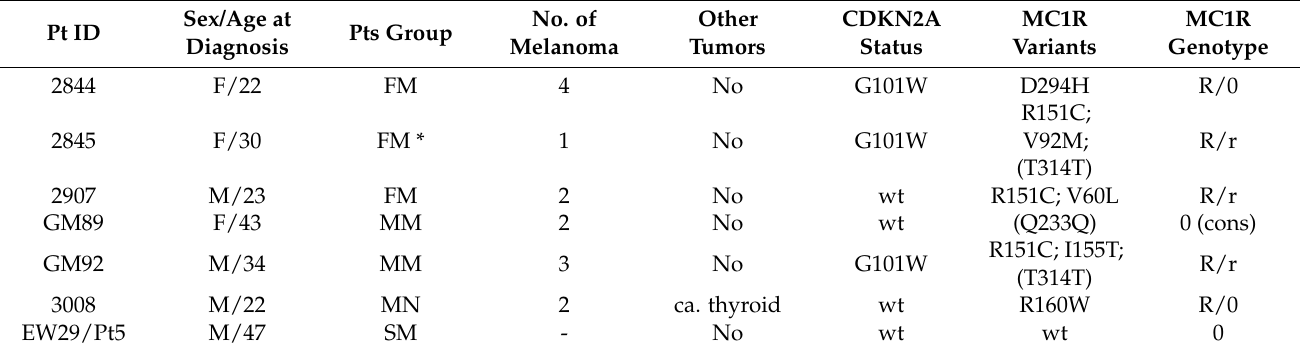
Table 2. Characteristics of the seven CM carriers of MITF-E318K